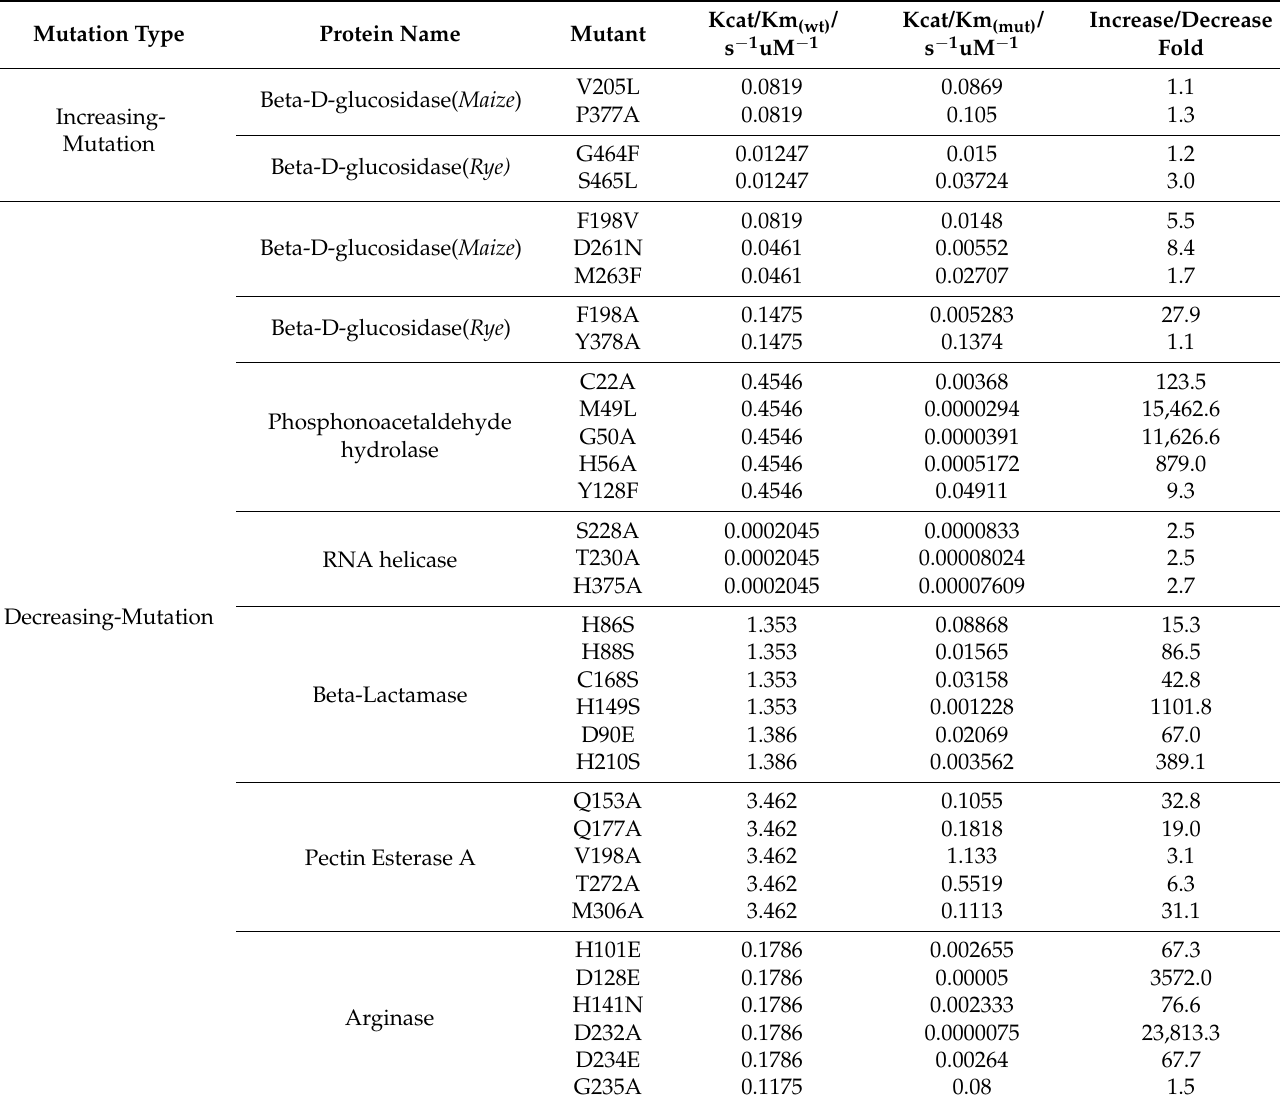
Table 3. Kcat/Km parameters of wild-type enzymes and their mutants.